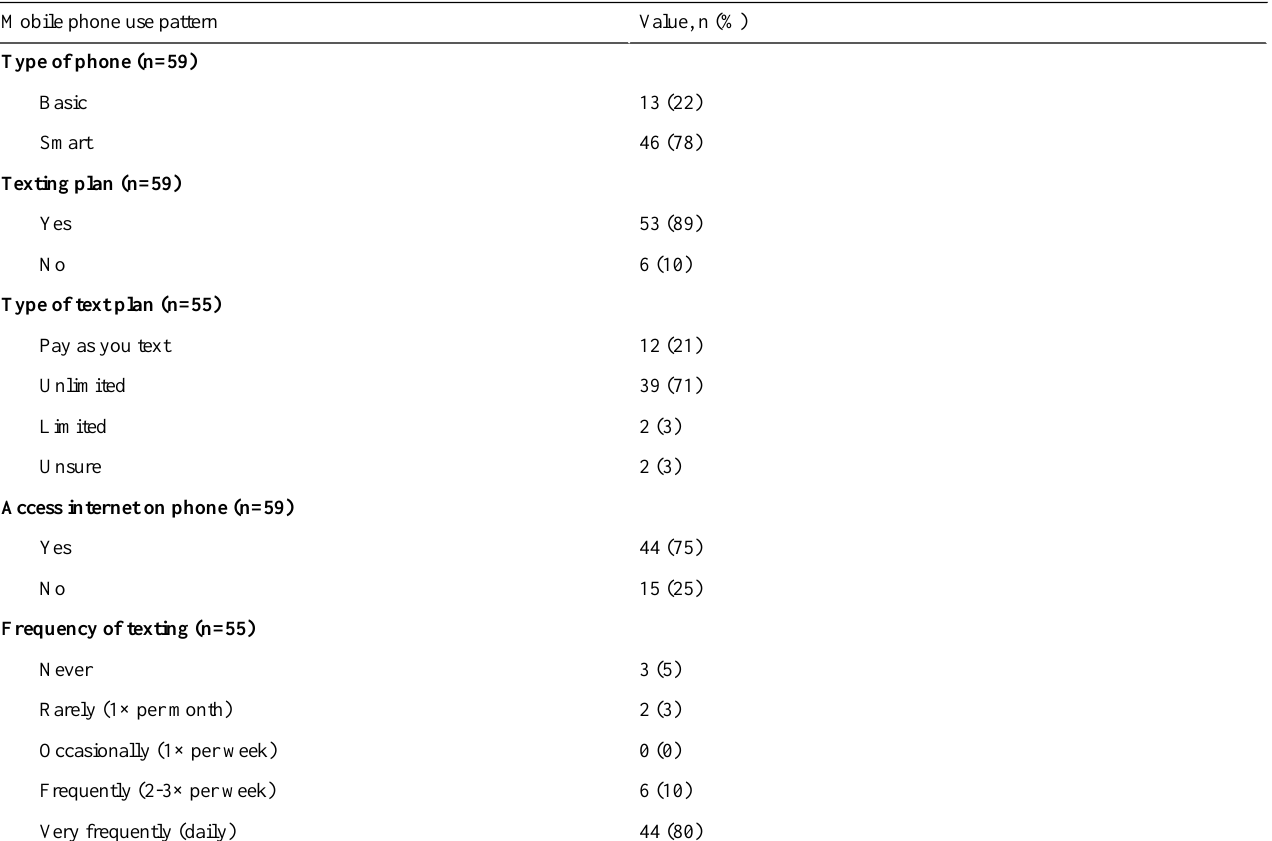
Table 2. Baseline mobile phone use patterns among young Indigenous people who have used drugs who reported owning a phone at enrollment into the Cedar Project WelTel Mobile Health Study